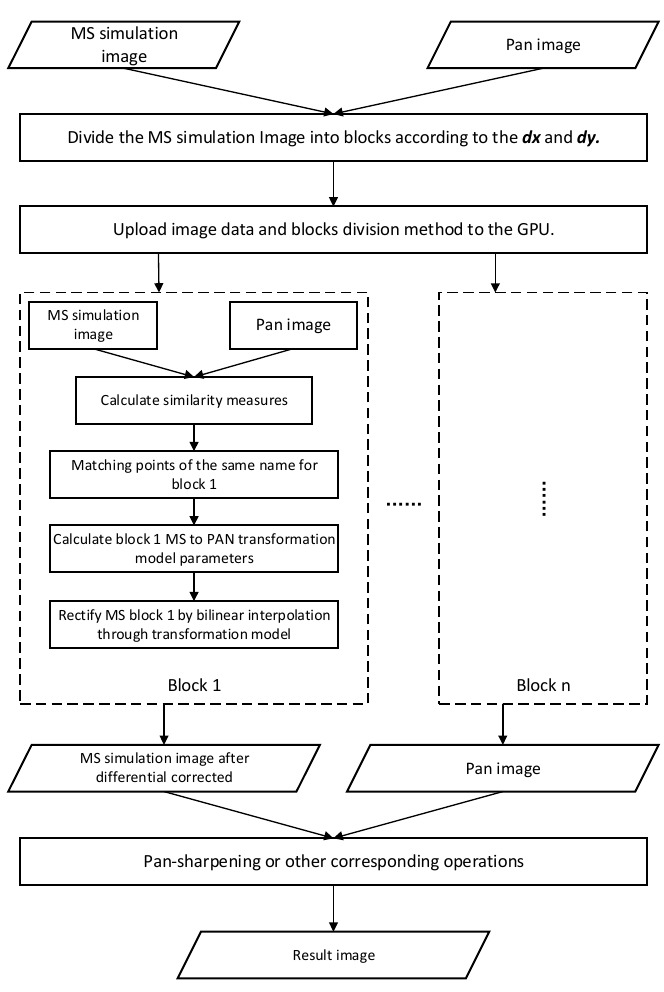
Figure 3. Differential rectification with tiny facet primitive. After extracting the points with the same name, it is necessary to calculate the trans- form relationship between each block. The perspective transformation is also used at this stage; please refer to Section 2.2. Bilinear interpolation is also used in subsequent differ- ential rectification; please refer to Section 2.2. Matching and rectification formulas were mapped to two different kernel functions for calculation.